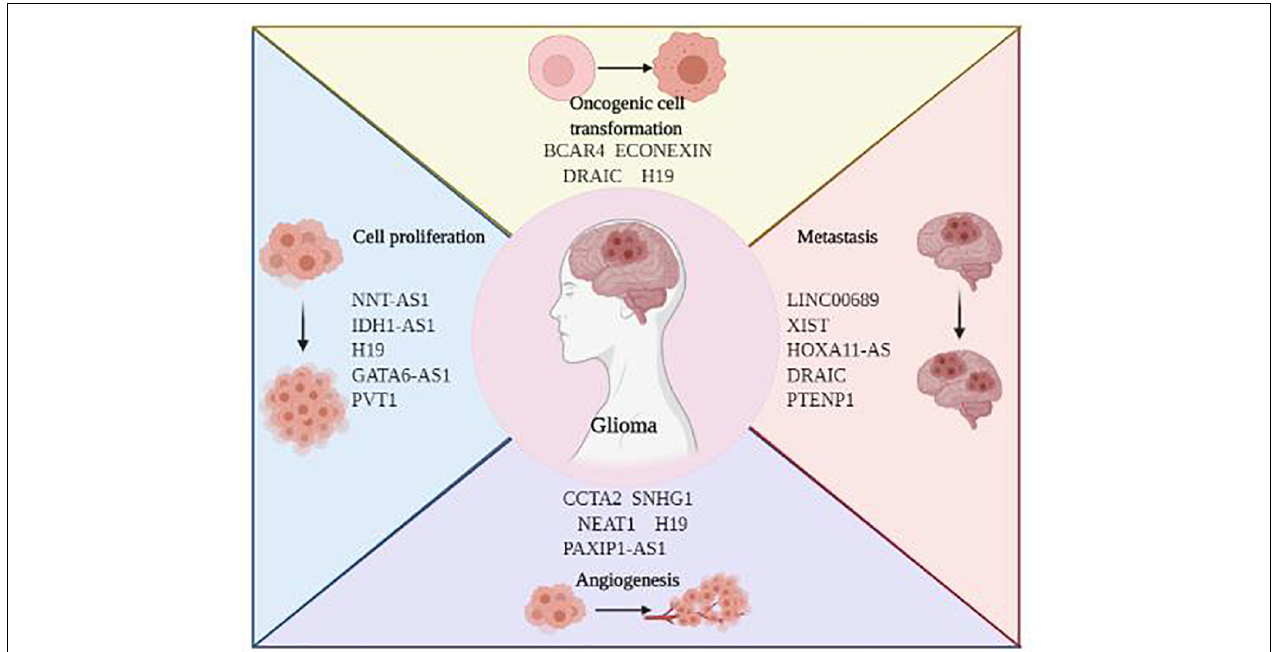
FIGURE 3 | The roles of LncRNAs in glioma development and